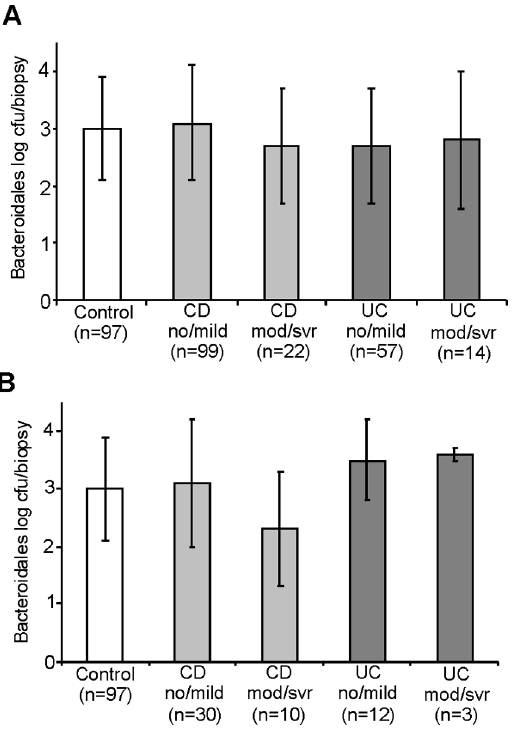
Figure 1. Total Bacteroidales (cfu/biopsy) by cohort and degree of inflammation. Biopsies were grouped by cohort: CD (Crohn Disease), UC (ulcerative colitis) and Control and degree of inflammation: no and mild inflammation (no/mild) or moderate to severe inflamma- tion (mod/svr). N is equivalent to the number of biopsies in each group. Column level represents mean Bacteroidales log cfu/biopsy. Error bars represent inter-quartile ranges A. Entire cohort. There were no significant differences detected between cohorts. B Includes only biopsies from newly diagnosed subjects.